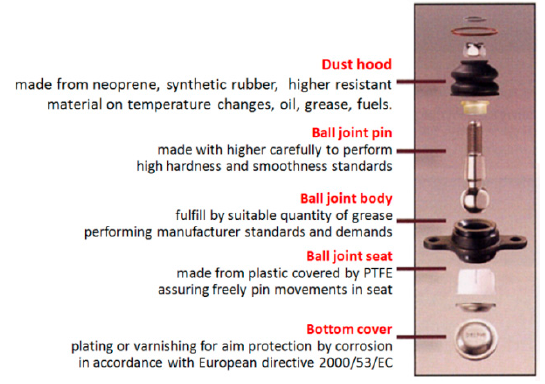
Figure 1. Components of a ball joint [8].